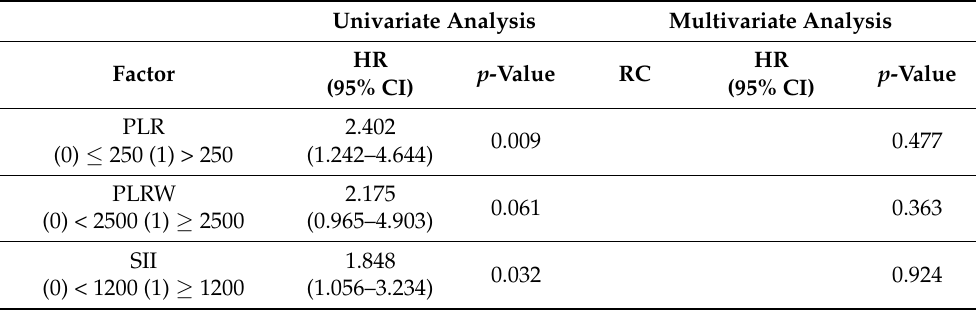
Table 2. Univariate and multivariate Cox regression analysis, using the stepwise method, of the OS rate’s predictive categorical